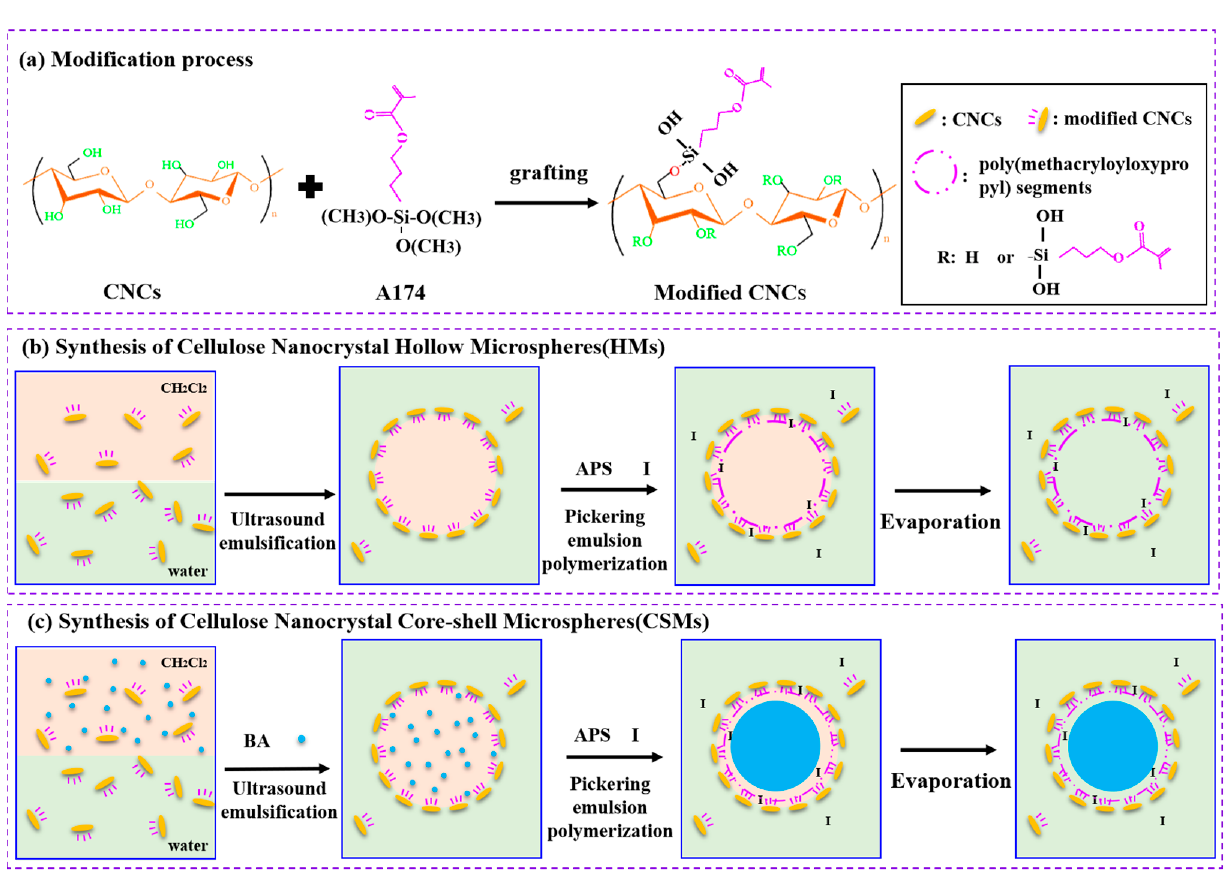
Figure 1. Schematic illustration of ( a ) CNCs modification process, synthesis of ( b ) HMs and ( c ) CSMs through Pickering emulsion polymerization and solvent evaporation process.